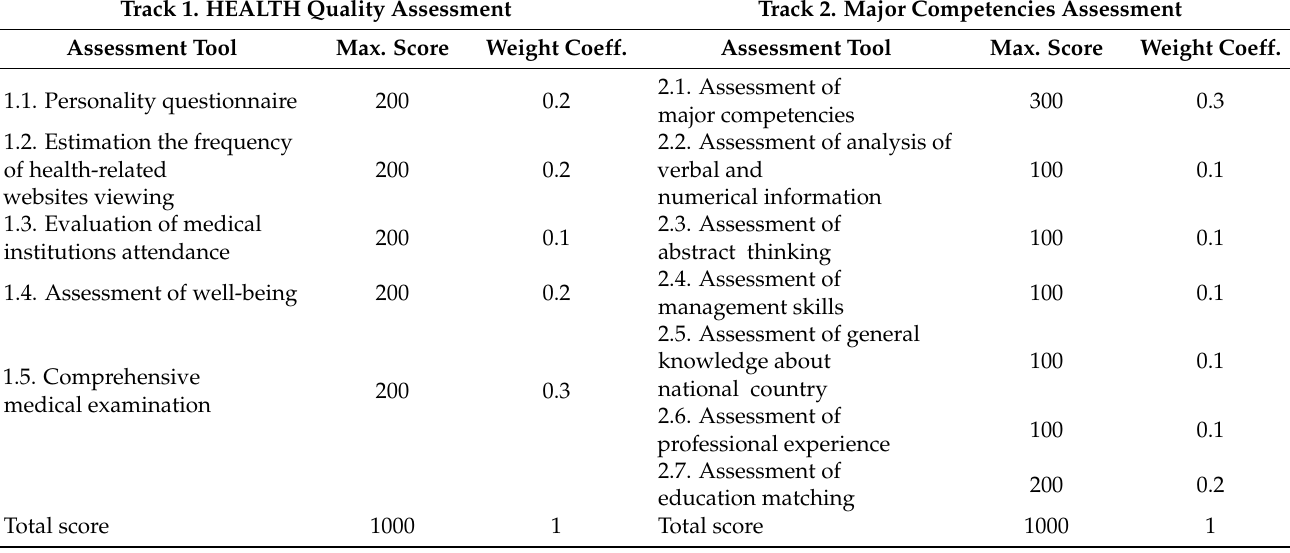
Table 3. Assessment of human capital components (Track 1, Track 2). Track 1. HEALTH Quality Assessment Track 2. Major Competencies